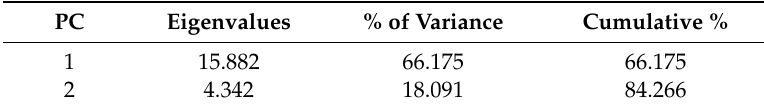
Figure 7. Principal component analysis (PCA) of Raman spectra of Caco-2 cells exposed to 100 μg/mL oxidized lipids for 24 h. The plot shows separation between PC1 and PC2. Treatments are related to 24, 48 and 72 h oxidized ML or fish oil (F). Table 4. PC solutions of the FT-Raman spectra data of untreated and treated Caco-2 cells with oxidized lipids.